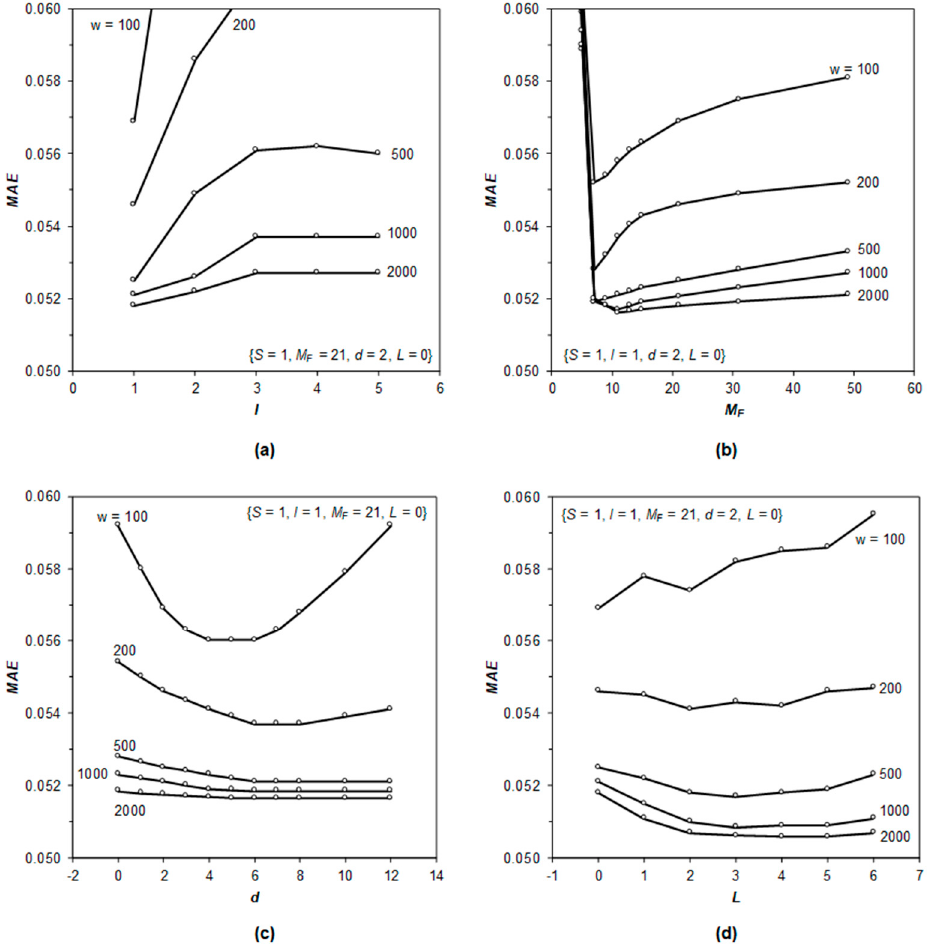
Figure 3. Comparison of the mean absolute error (MAE) as a function of model hyperparameters: ( a ) Order of interaction between input variables, I ; ( b ) maximum number of functions in the forward phase, M F ; ( c ) penalty for model complexity, d ; and ( d ) lagged terms as additional inputs, L . Each single point in a curve comprises 8000 evaluations of the model, from t = 2000 to t = 10,000.